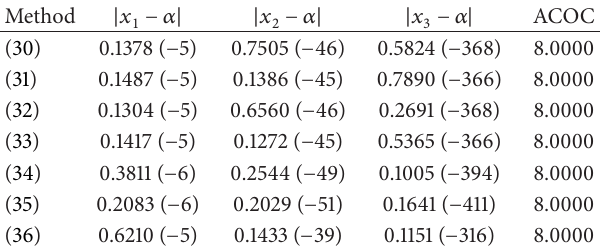
Table 1: Numerical results with 𝑓 1 .